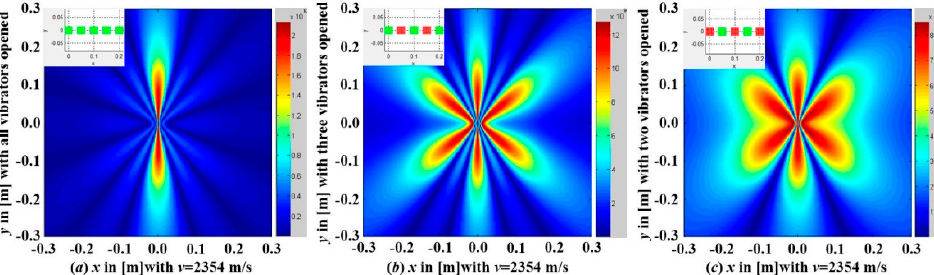
Figure 8. Ultrasonic near field pressure in the XY plane with v = 2345 m / s.